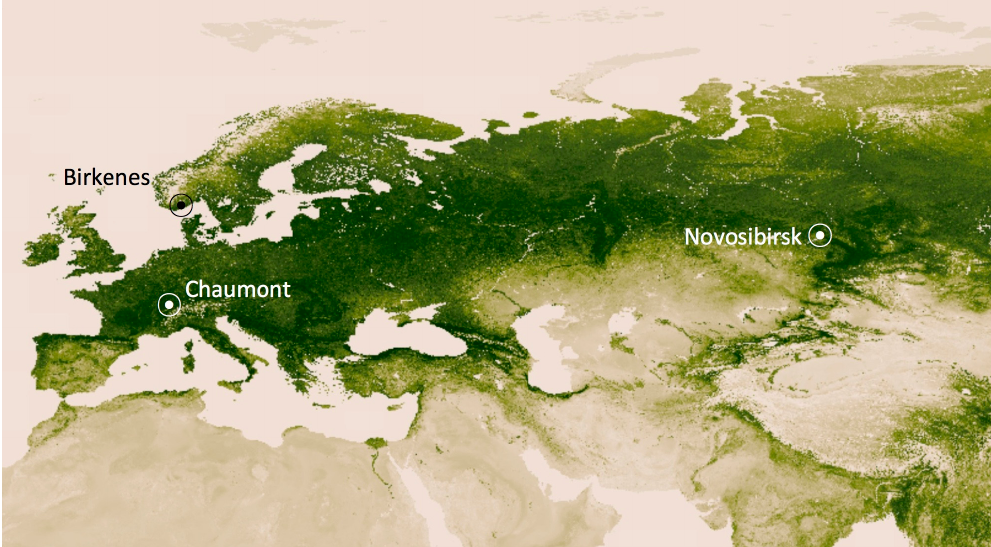
Figure 1. Locations where INP − 8 were measured over the course of 12 months. The background image shows the distribution of green vegetation. The darkest green areas are the lushest in vegetation [11].